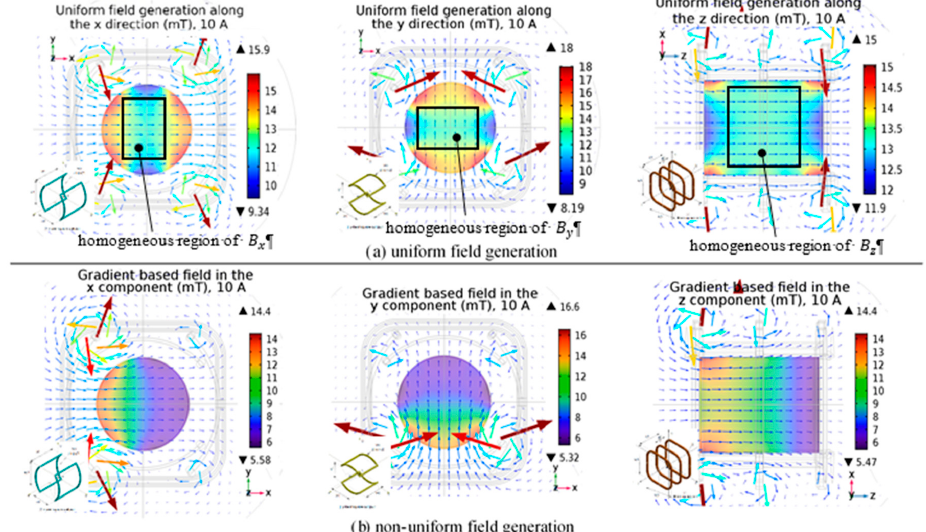
Figure 6. Numerical simulations of magnetic field generation by the HyBrid system. ( a ) uniform field distribution in the x, y, and Z component forms a homogeneous region at the center of the cylindrical workspace. ( b ) non-uniiOrm field of each Component is at a minimum of about 9 mT with a gradient of about 100 mT/ m.